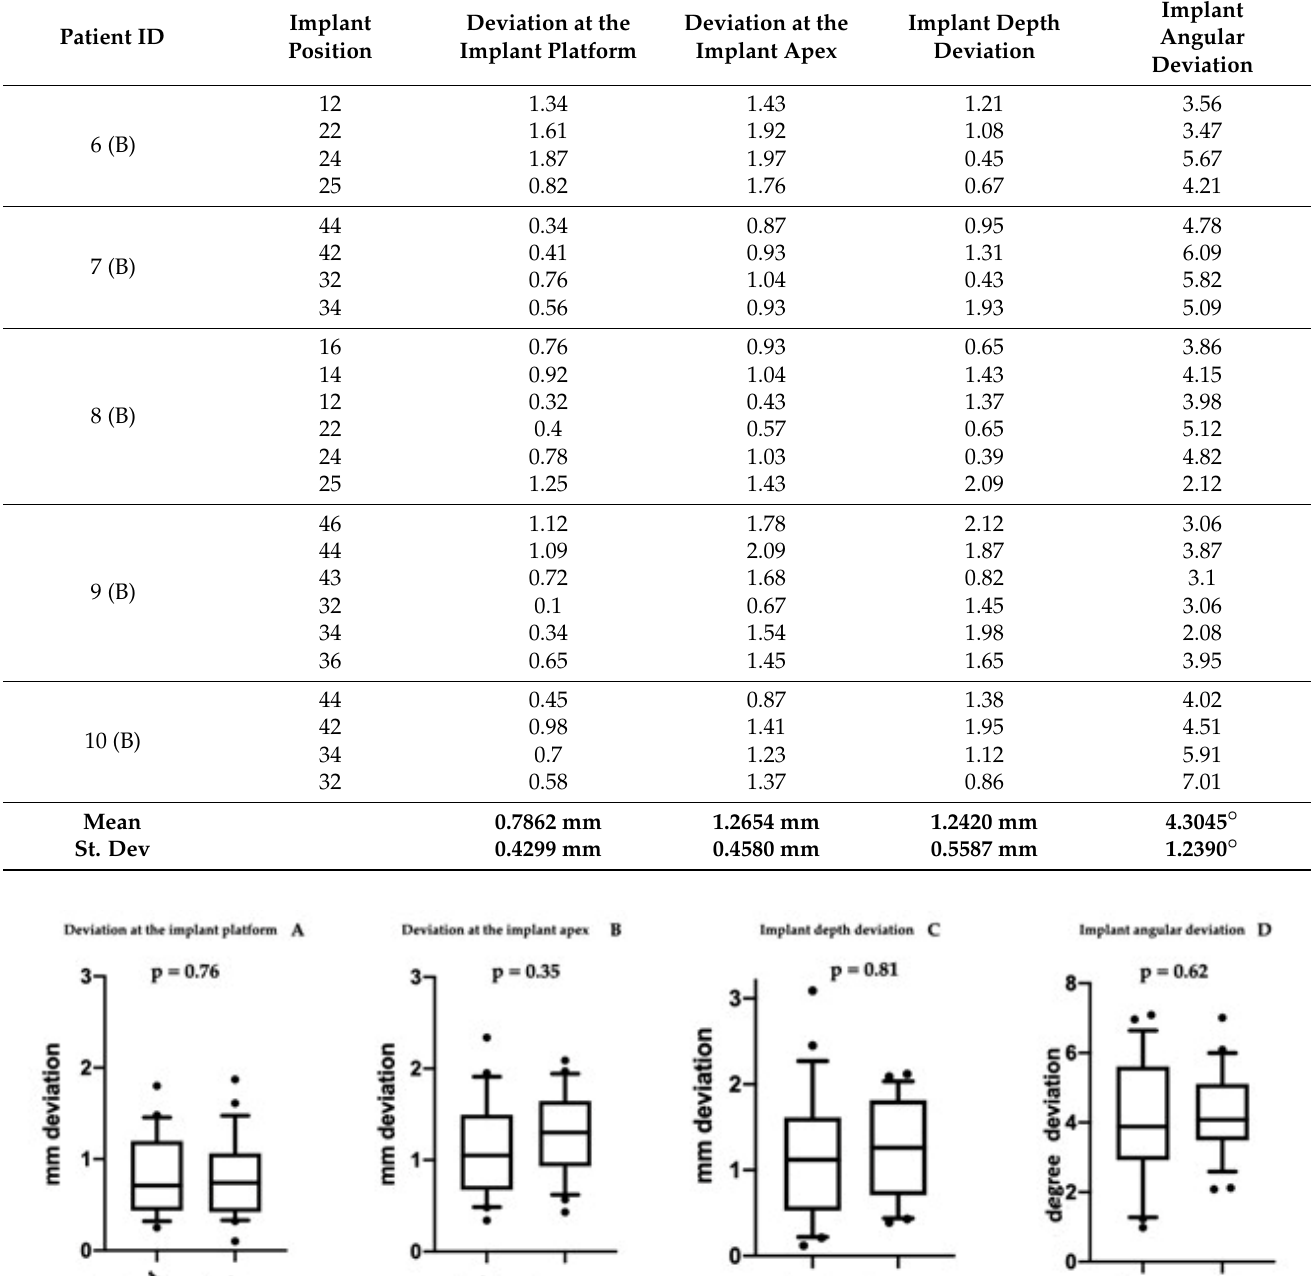
Table 3. Deviation measured in patients of group B.